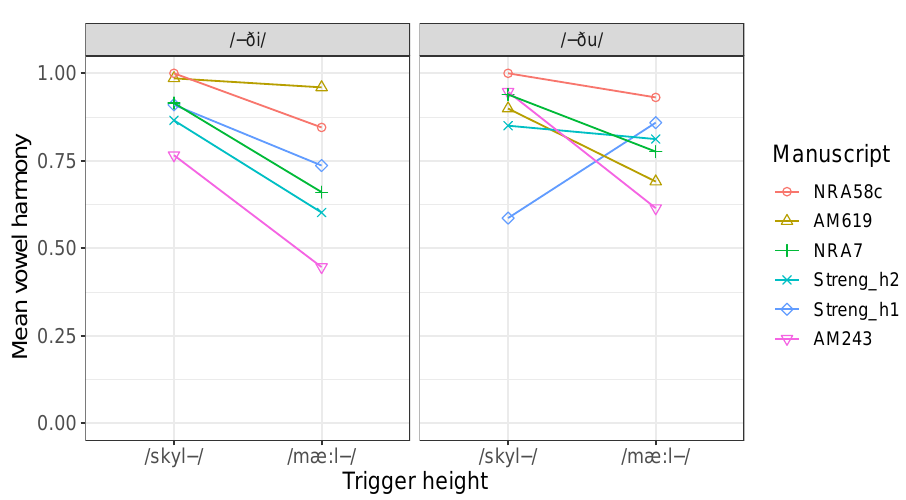
Figure 10: Varying harmony levels on front/back harmony targets follow- ing non-/high harmony triggers in intermediary decaying manuscripts much more variation across the manuscripts, with 1) fairly even levels of harmonisation in NRA58c and Streng_h2; 2) levelling towards /-ðu/ in AM619, NRA7, and AM243; and 3) levelling towards /-ðo/ in Streng_h1. Though AM619 displays nearly categorical harmonisation in all other contexts, it features signi(cid:976)icantly less harmonic lowering on back vowel targets in the right graph in Figure 10. This represents a trend towards levelling back vowel suf(cid:976)ixes as high /-u/ – especially before a follow- ing /m/, as in the dative plural suf(cid:976)ix in nouns/adjectives or the 1st person plural /-um/ suf(cid:976)ix in verbs. This leaves around 30% dishar- monic back vowel in(cid:976)lectional suf(cid:976)ixes in AM619 following lowering trig- gers like /mæːl̥-/. This levelling shows no clear morphological condition- ing and is displayed in all word types: e.g. [ɡoːð-um] <goðum> ‘good’- (cid:265)(cid:262)(cid:281).(cid:277)(cid:273).; [ɡer-ðu] <gerðu> ‘do’-(cid:277)(cid:279)(cid:266)(cid:281).3.(cid:277)(cid:273).(cid:270)(cid:275)(cid:265)(cid:270)(cid:264).; [heːt-um] <hetu m > ‘call’- (cid:277)(cid:279)(cid:266)(cid:281).1.(cid:277)(cid:273).(cid:270)(cid:275)(cid:265)(cid:270)(cid:264).; and [klæːð-um] <clæðum> ‘clothes’-(cid:265)(cid:262)(cid:281).(cid:277)(cid:273).; instead of height-harmonic *[ɡoːð-om, ɡer-ðo, heːt-om,